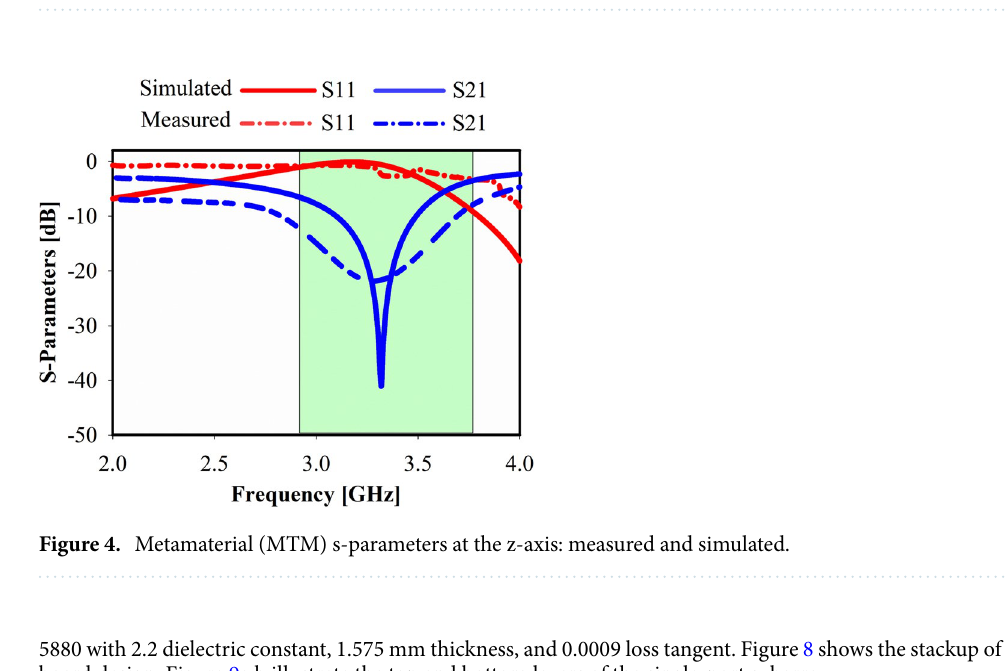
Figure 3. Unit cell surface current distribution at ( a ) 3.4 GHz, ( b ) 3.5 GHz.